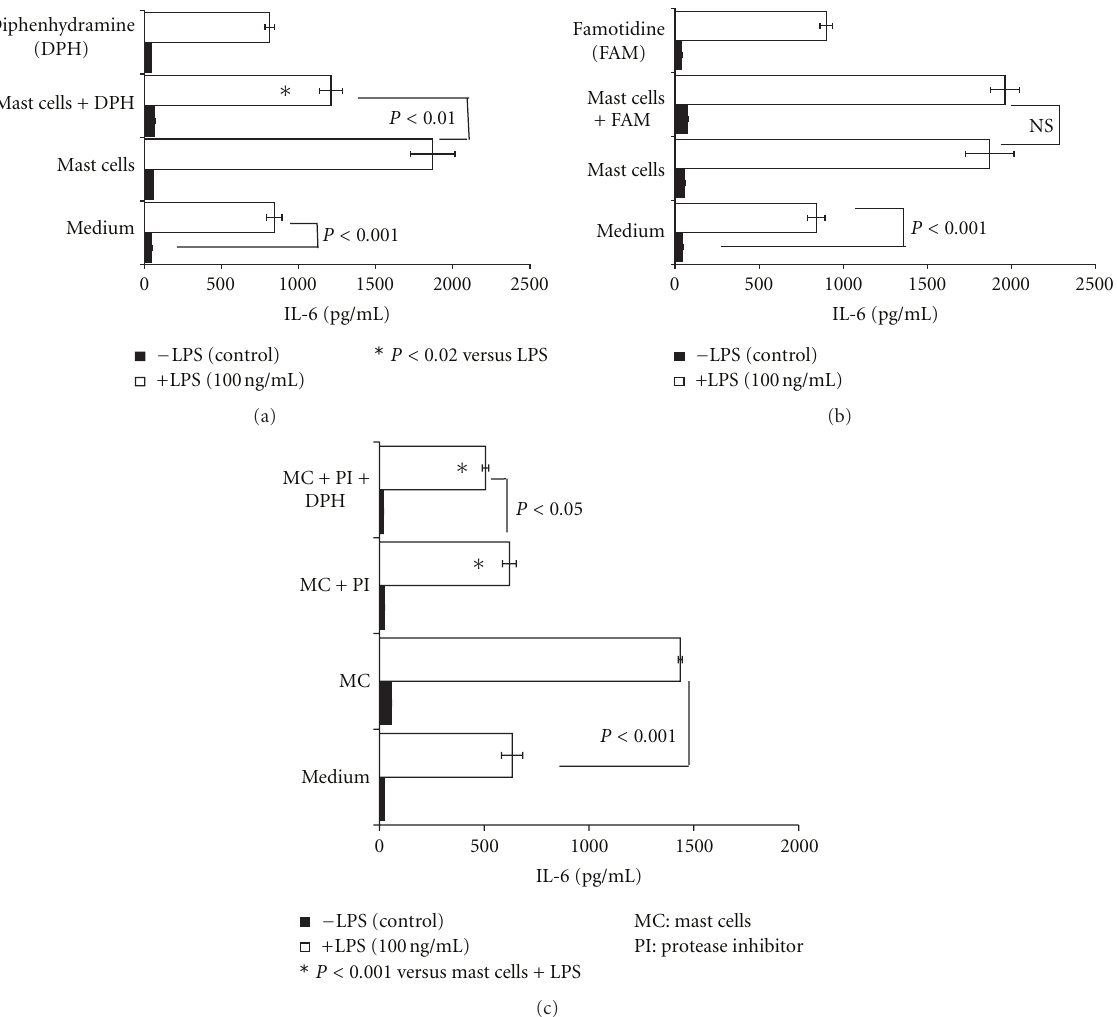
Figure 4: Combination of H1R antagonist and protease inhibitors (PI) abrogates mast cell- (MC-) mediated potentiation of IL-6 production by LPS-stimulated endothelial cells. Endothelial cells (10,000cells/well) were grown for 24h in the presence of mast cells (5000 cells/well) and were activated with LPS (100ng/mL) for a period of 24 h. To determine the e ff ect of H1R or H2R antagonists, endothelial cells were incubated with 10 μ M diphenhydramine (DPH) (a) or 10 μ M famotidine (FAM) (b) for 30min before addition of HMC-1 5C6. To determine the contribution of mast cells proteases (c), HMC-1 5C6 were pretreated with protease inhibitor (PI) cocktail overnight, washed twice, and then added to endothelial cell monolayers. After 24h incubation, the culture supernatants were analyzed for IL-6 by ELISA. Results are mean ± SEM of quadruplicate determinations of a representative experiment. Similar results were observed in two other